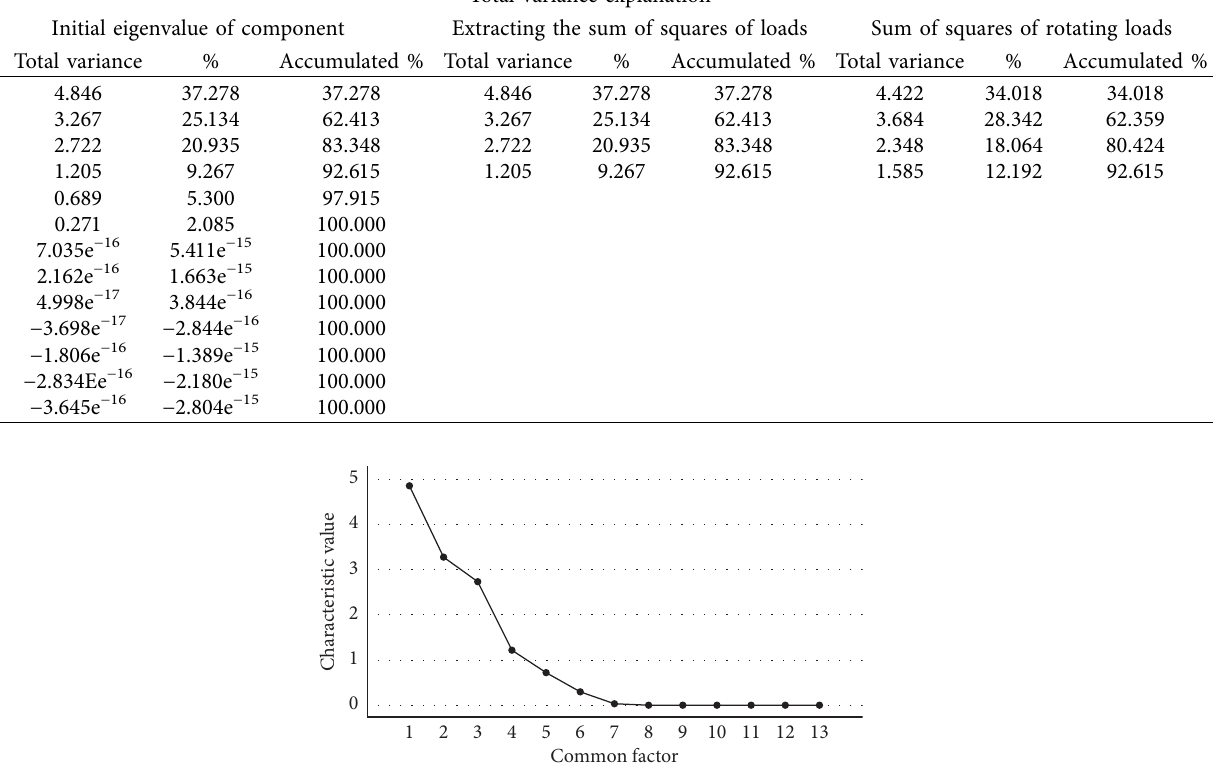
Table 2: Explanation of total variance of incense burners in the Ming Dynasty.